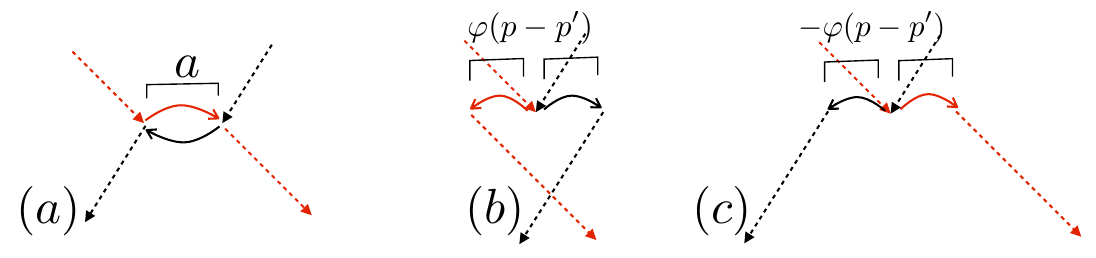
Figure 16: (a) The quasiparticle jump in the hard rod case, see Fig. 9. (b) The flea-gas quasiparticle jump, for ϕ ( p − p (cid:48) ) > 0 (backward jump). (c) The flea-gas quasiparticle jump, for ϕ ( p − p (cid:48) ) < 0 (forward